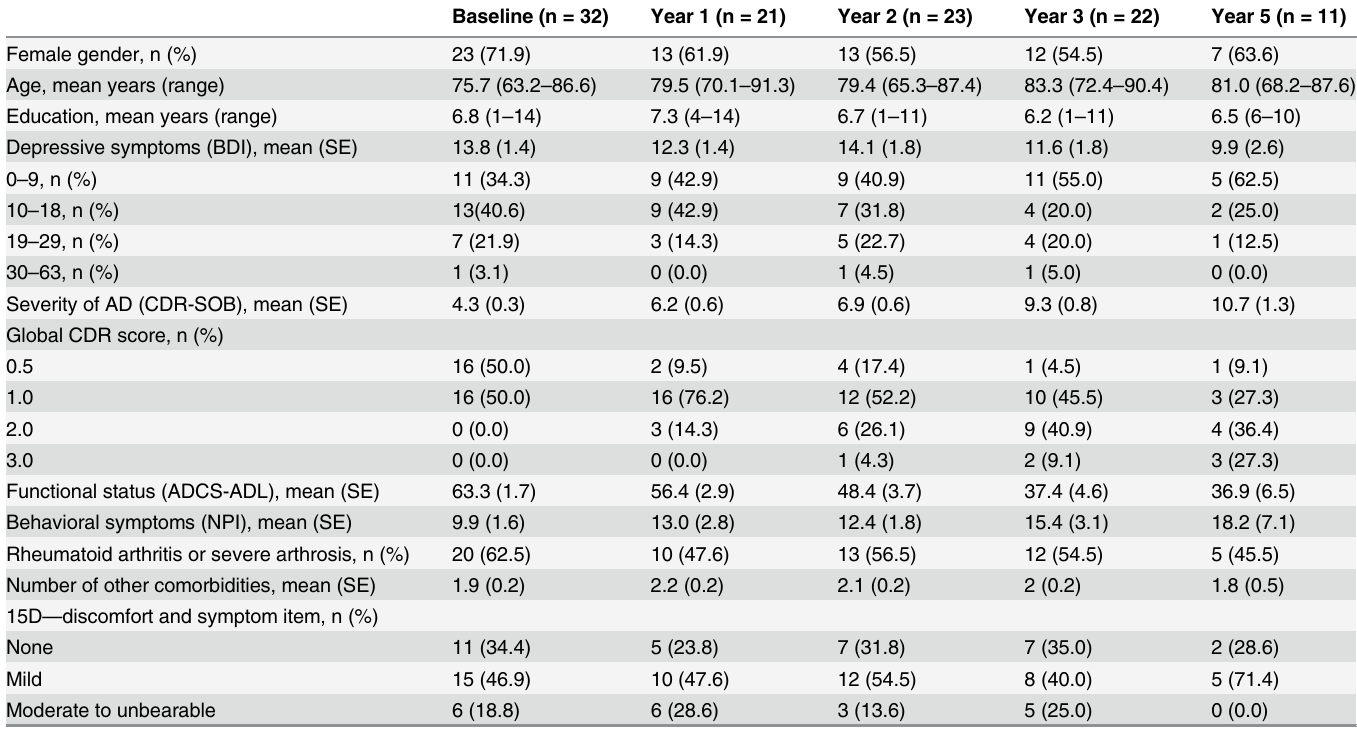
Table 3. Characteristics of persons with AD who used analgesics over the fi ve year